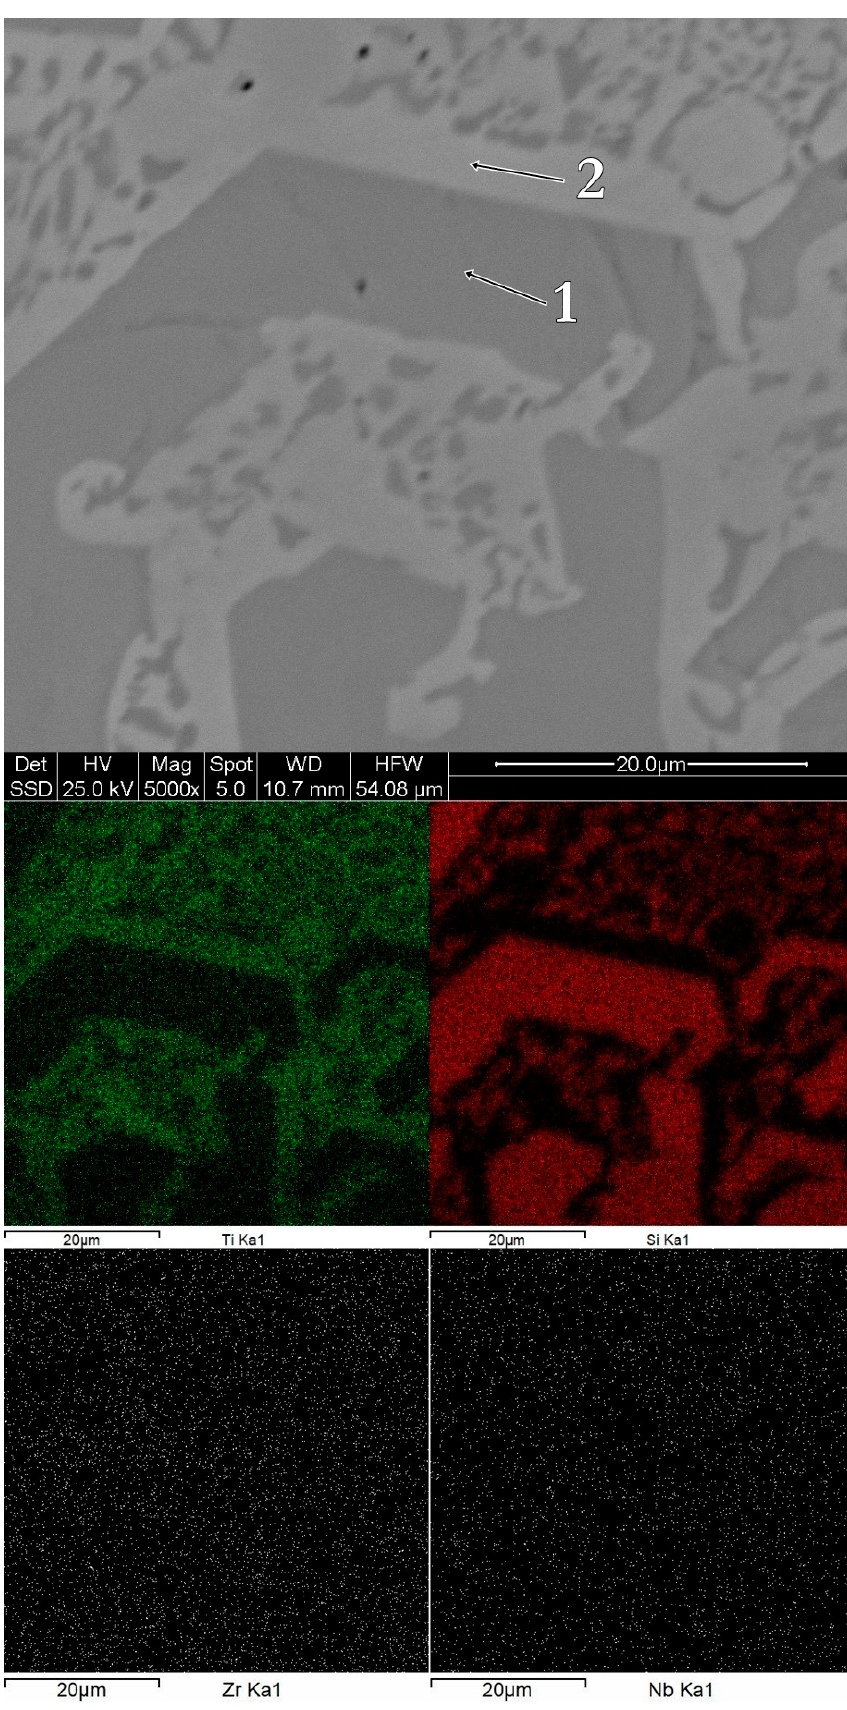
Figure 6. Surface morphology and chemical mapping for the bulk Ti 64 Zr 10 Si 15 Nb 11 alloy.